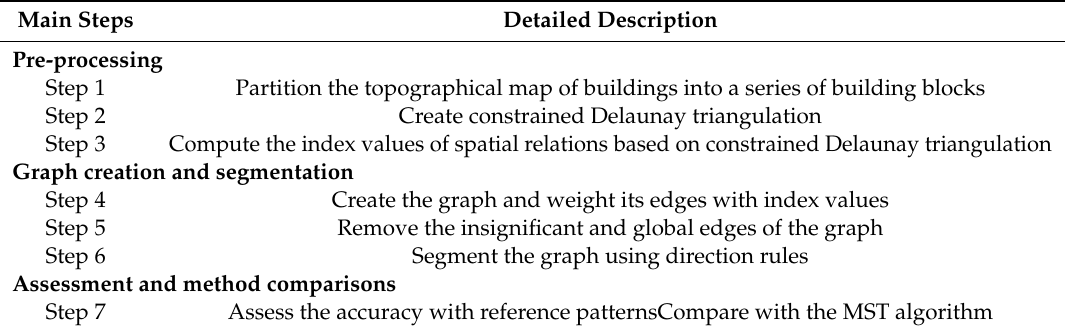
Table 1. Methodological steps.